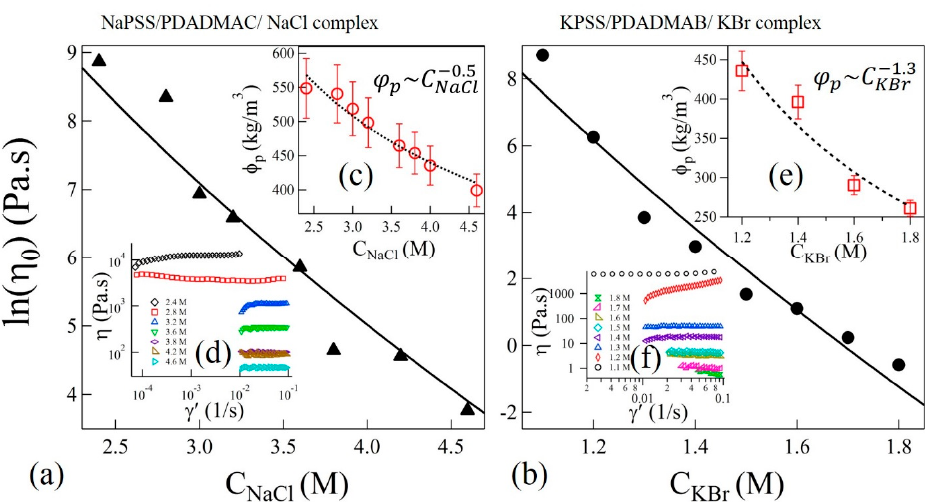
Figure 5. Variation of zero-shear viscosities η 0 as functions of ( a ) C NaCl and ( b ) C KBr . Solid lines are fit to Equation (4). The insets ( c , e ) in ( a , b ) show the variation of polymer concentrations in complexes and power-law fits (dotted lines) as functions of C NaCl and C KBr , respectively. Shear viscosities ( η ) as functions of shear-rate ( γ ’) at varying concentrations NaCl and KBr are shown in the insets of ( d , f ), respectively.